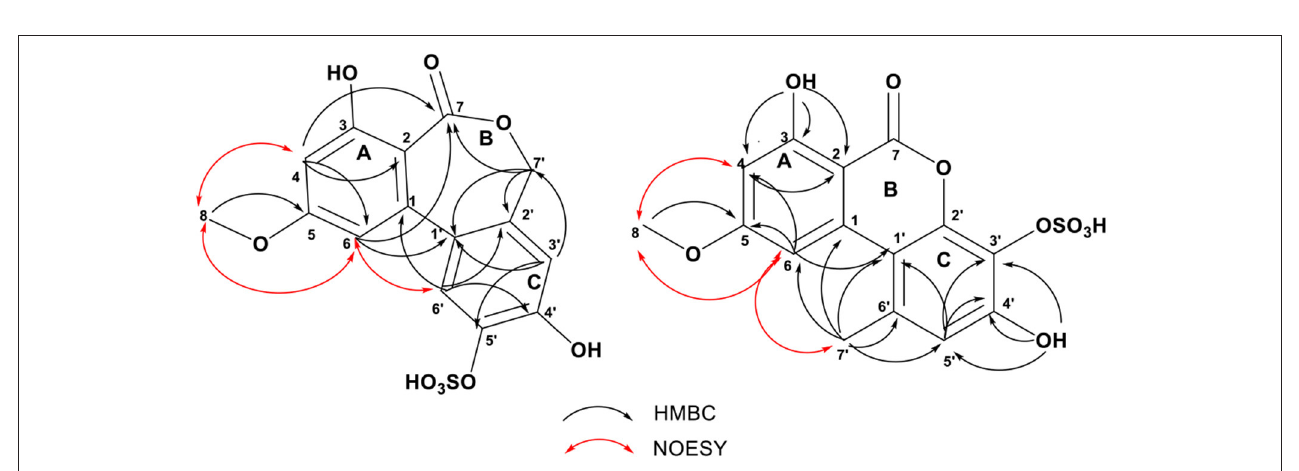
FIGURE 2 | Selection of the target strain. (A) Three strains; (B) Chemical screening [Thin layer chromatography (TLC) and high pressure liquid chromatography (HPLC)]; (C) Antibacterial activity screening.